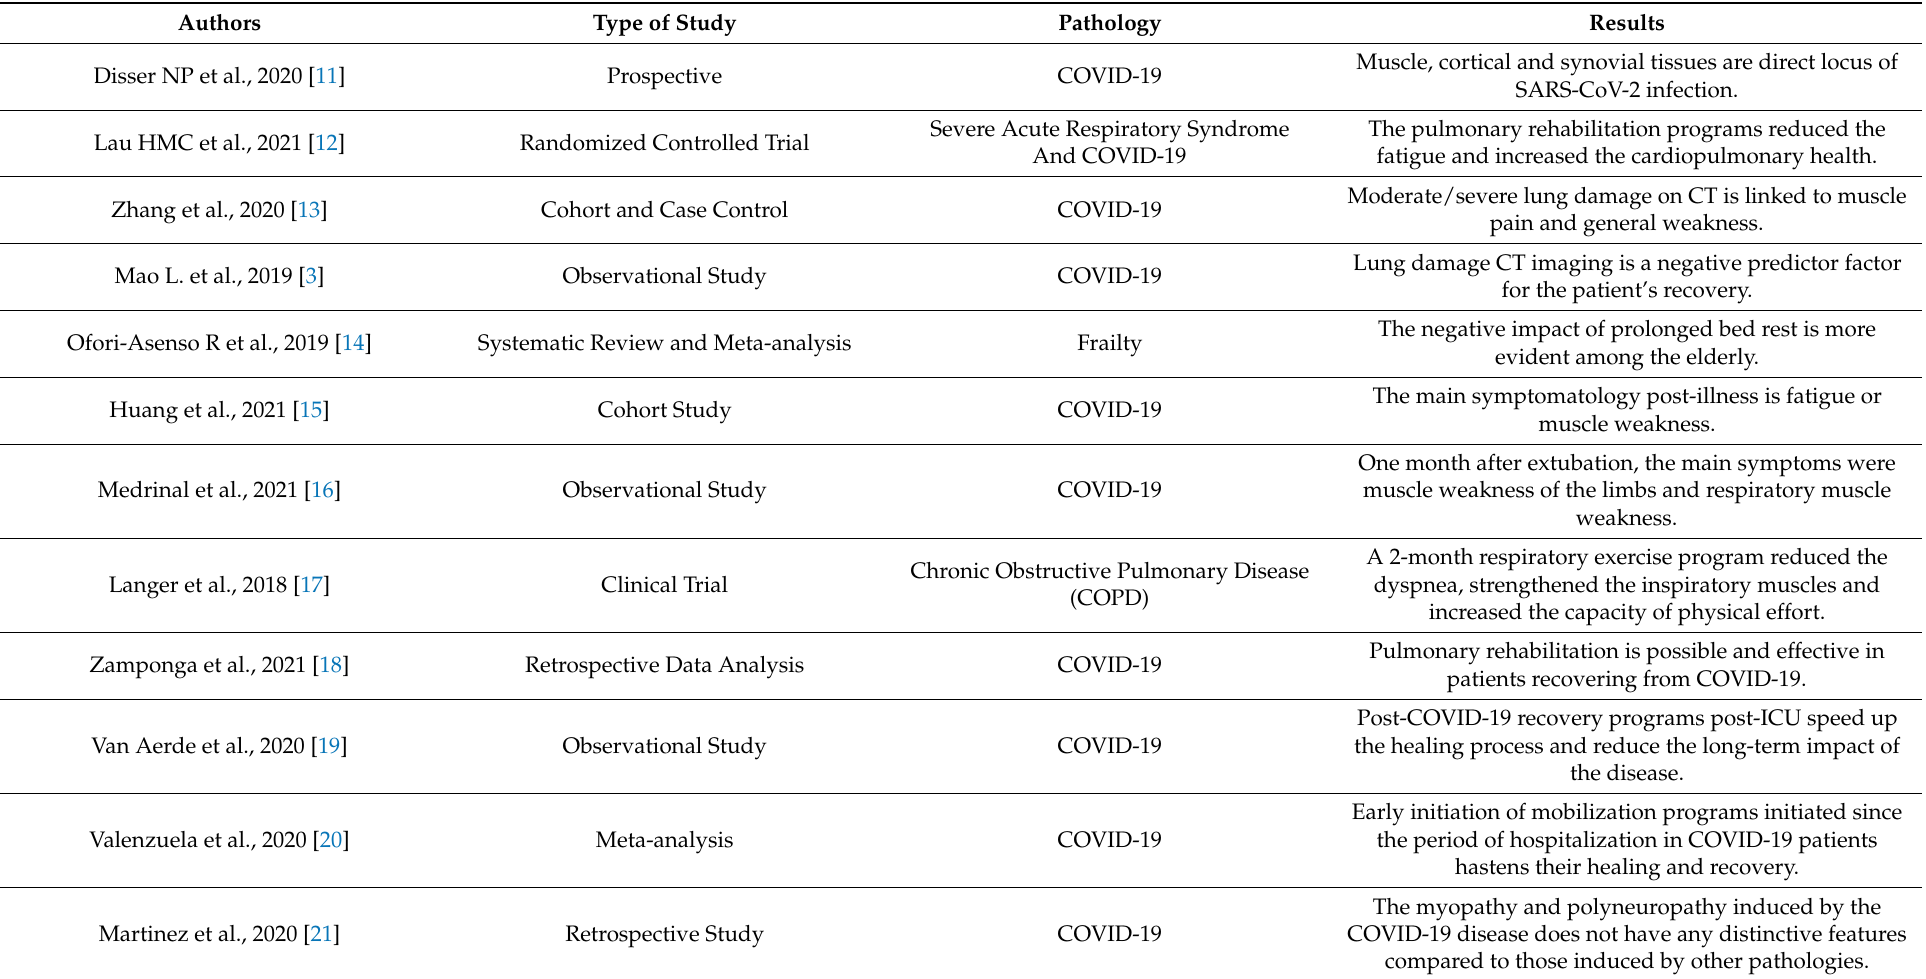
Table 1. Literature review of researched